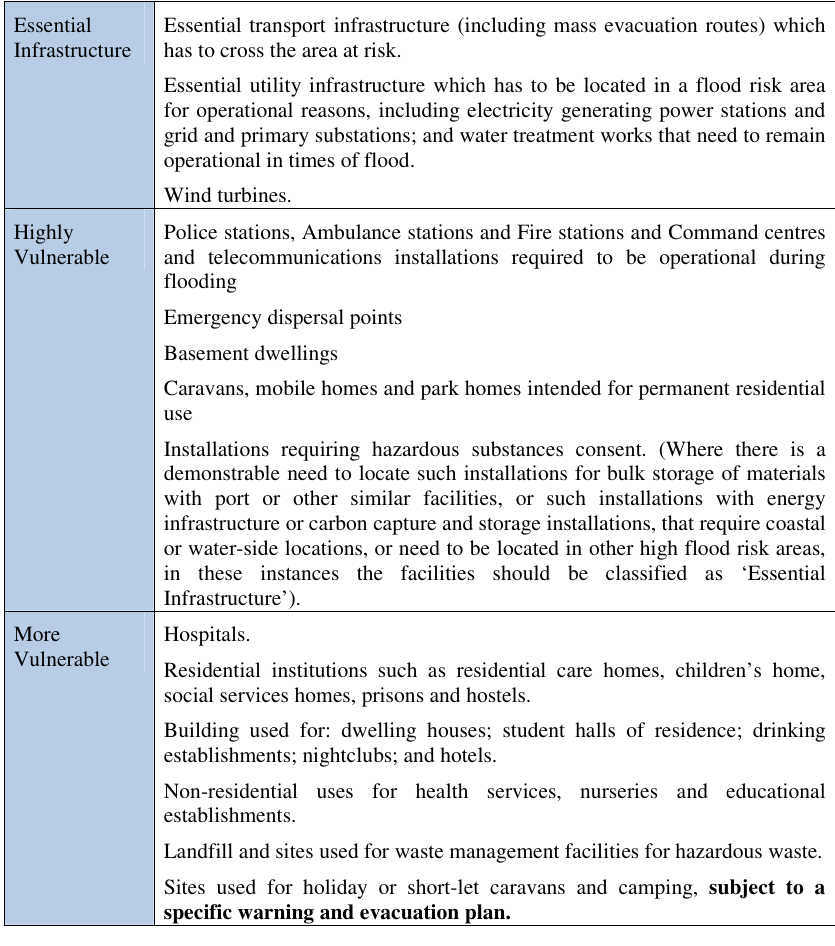
Fig. 3. The sequential test classification of development types (from PPS 25, Table D2) 5